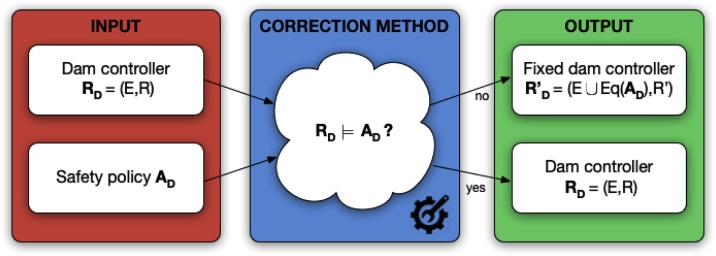
Correction workflow.